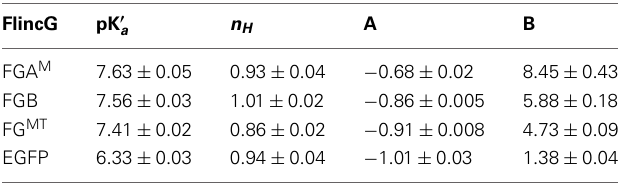
Table 3 | pH-sensitivity parameters in FlincG-transfected HEK GC / PDE5 cells.